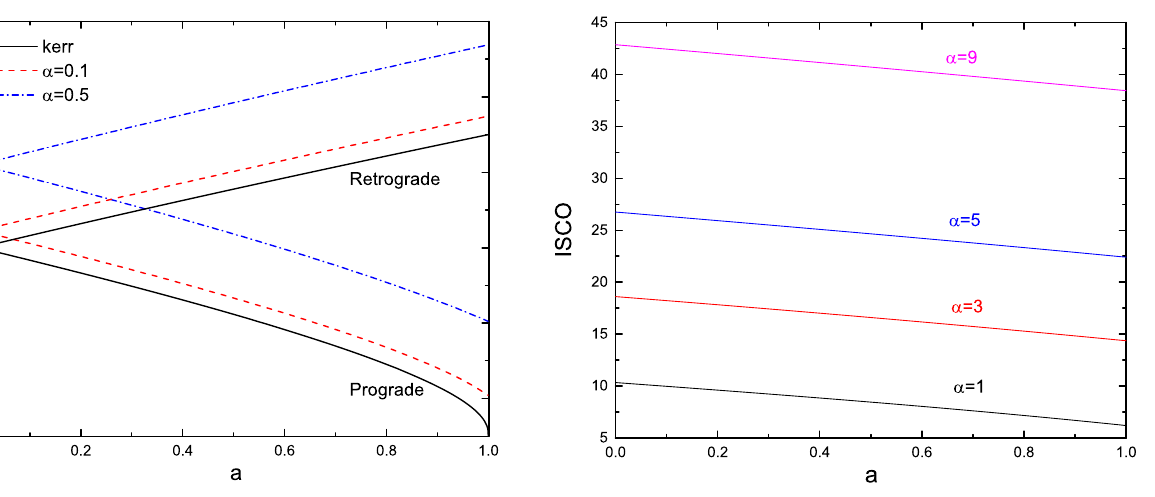
Fig. 12 ISCOs of Kerr-MOG black holes with large values of α .